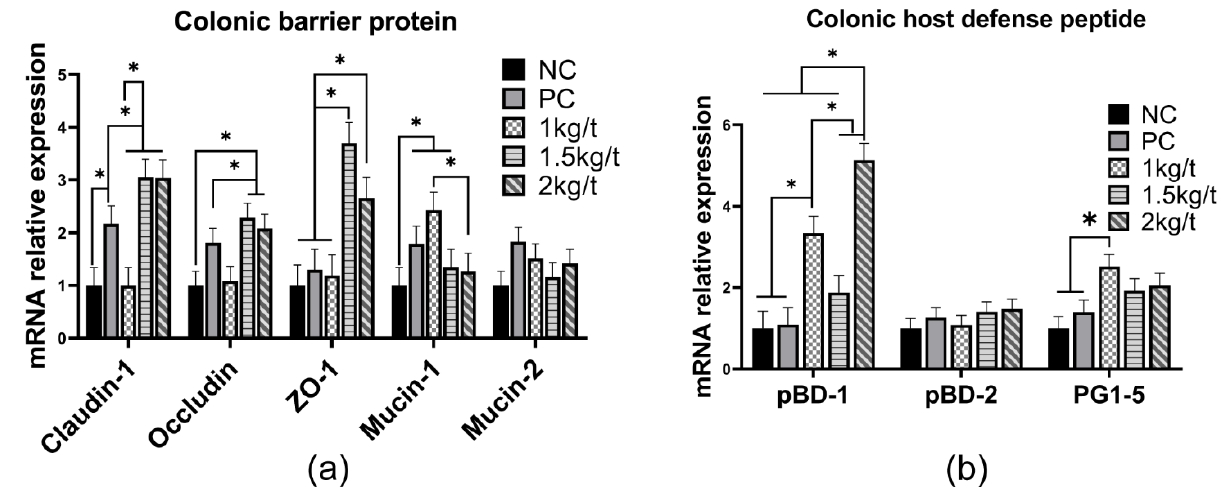
Figure 6. Effects of joint application of Lactobacillus plantarum and Bacillus subtilis on mRNA expression of colonic tight junction proteins protein and host defense peptides in weaned piglets. ( a ) The mRNA relative expression of colonic barrier protein. ( b ) The mRNA relative expression of colonic host defense peptide. “*” means there were statically significant differences ( p < 0.05). NC, a control diet; PC, NC + 150 ppm mucilage sulfate.